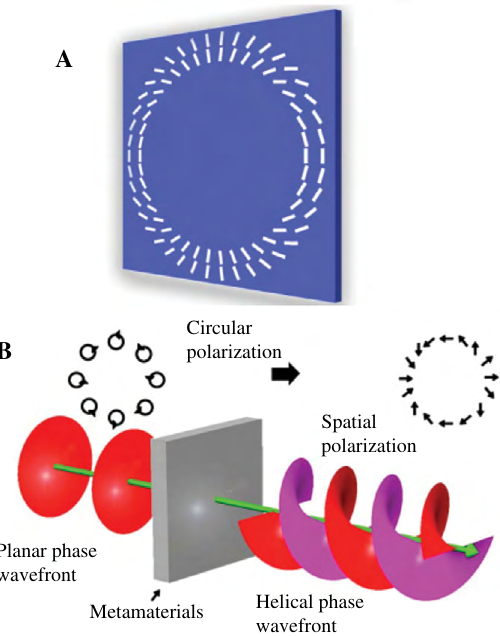
Figure 13 (A) Schematic structure of metasurface for generating OAM-carrying vector beams. (B) Illustration of generation OAM- carrying vector beam. Adapted from Ref.